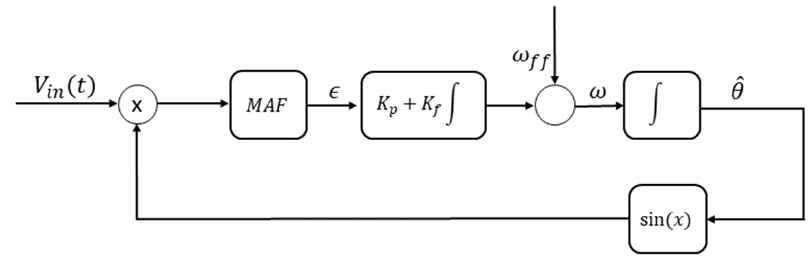
Figure 9. Diagram of the MAF-PLL.